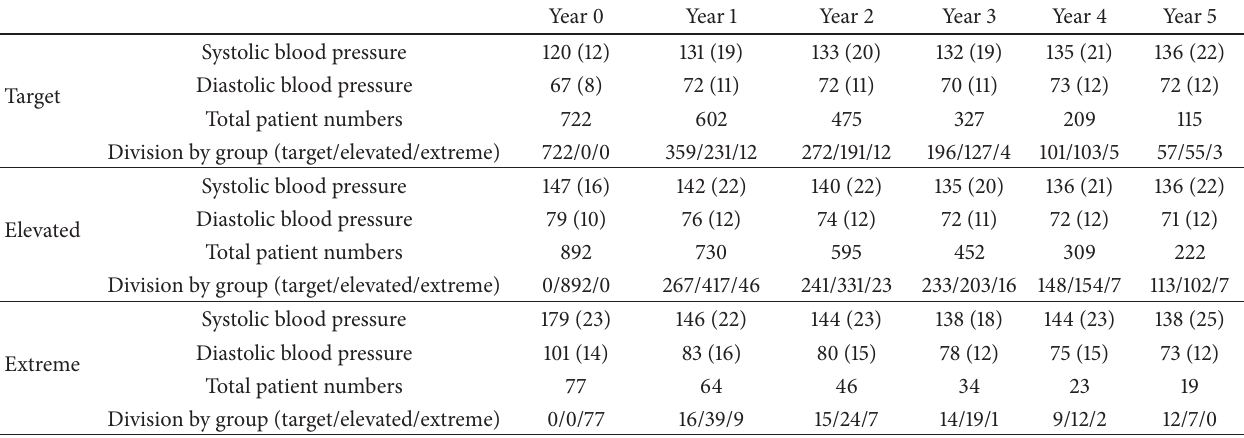
Table 5: Long-term within-group changes in blood